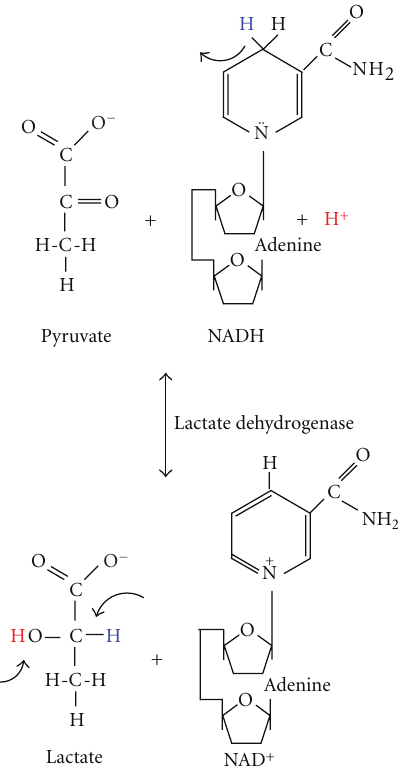
Figure 10: The lactate dehydrogenase reaction. Note the use of the proton to complete the reduction of pyruvate to lactate. Furthermore, the metabolic proton bu ff ering provided by lactate production is largely pH